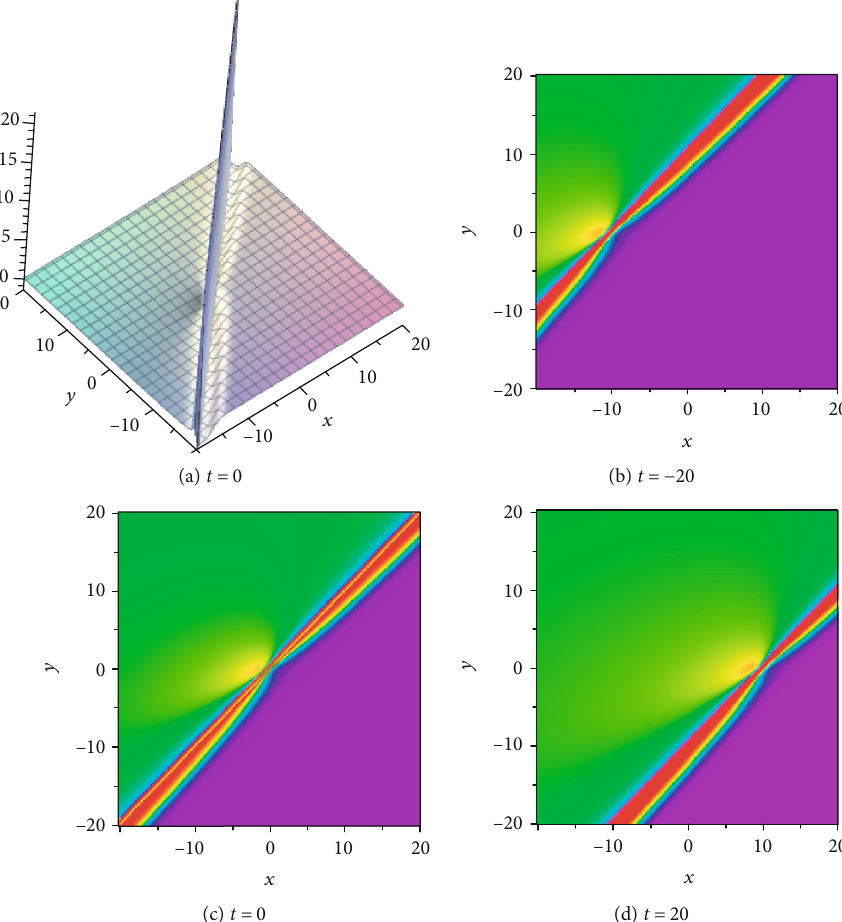
= 2 , k = 1 , and k = 0 . (a) 3-dimensional plot 2 3 4